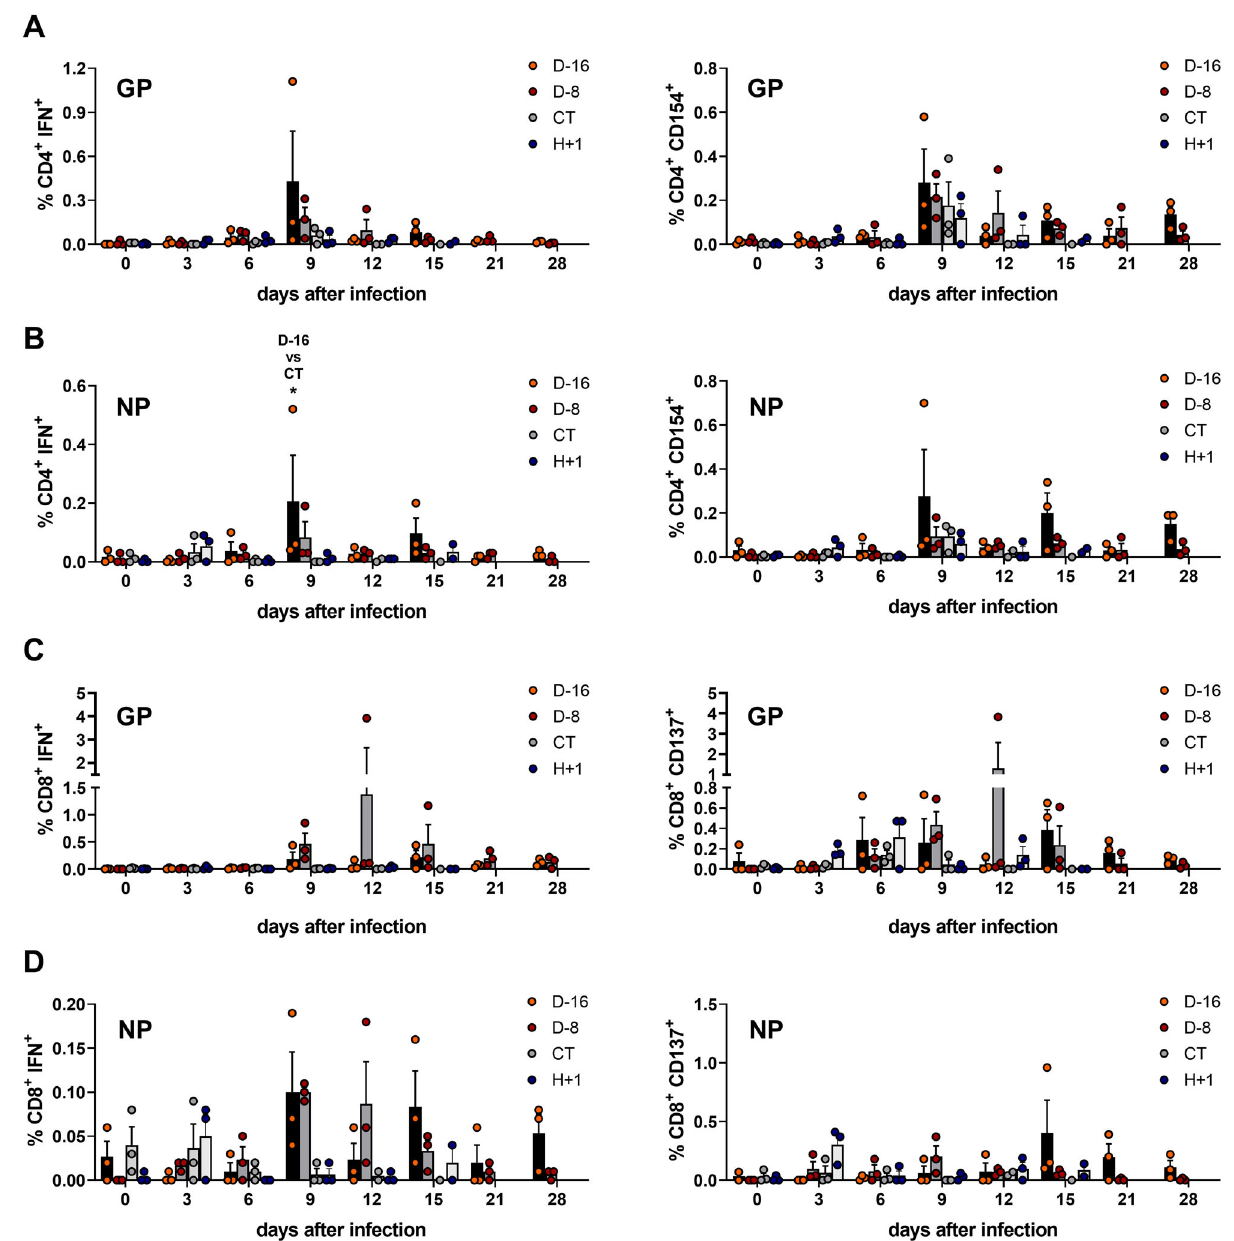
Fig. 5 | LASV-speci fi c T-cell responses induced after LASV challenge. A Quanti fi cation of the percentage of CD4 + T cells expressing IFN γ (left panel) or CD154 (right panel) in response to stimulation with LASV-derived GP peptides. B Quanti fi cation of the percentage of CD4 + T cells expressing IFN γ (left panel) or CD154(rightpanel)inresponsetostimulationwithLASV-derivedNPpeptides(D-16 vs CT, p =0.0382). C Quanti fi cation of the percentage of CD8 + T cells expressing IFN γ (left panel) or CD137 (right panel) in response to stimulation with LASV-